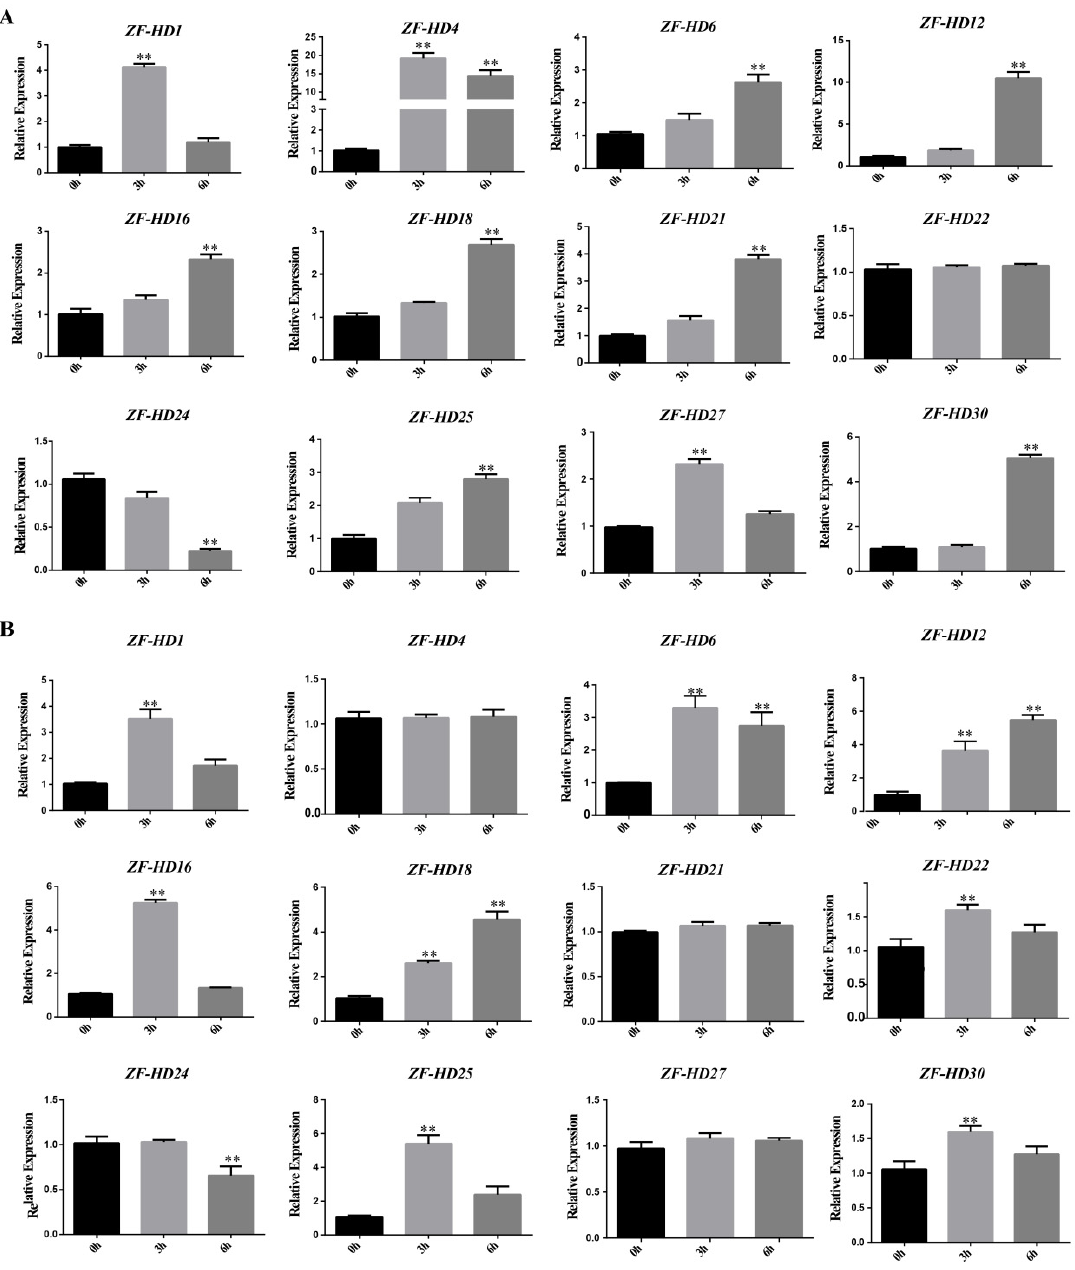
Figure 4. The expression patterns of selected NtZF-HD genes under ( A ) drought and ( B ) NaCl. The asterisks indicate significant statistical differences from the 0 h using the Student’s t test ( p < 0.005).